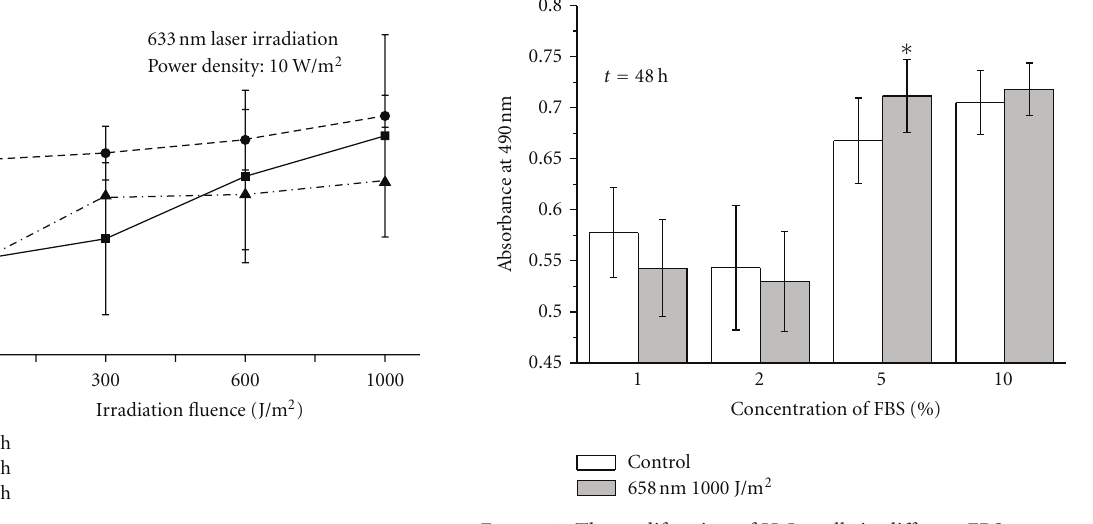
Figure 2: The viability of HeLa cells irradiated with LIL at 633 nm in 5% FBS. The laser power density was 10W/m 2 . Error bars were from three independent experiments.